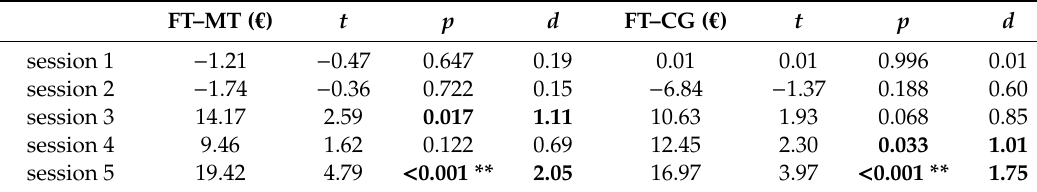
Table 3. Statistics for group comparisons for 5 sessions for overall IGT gains.